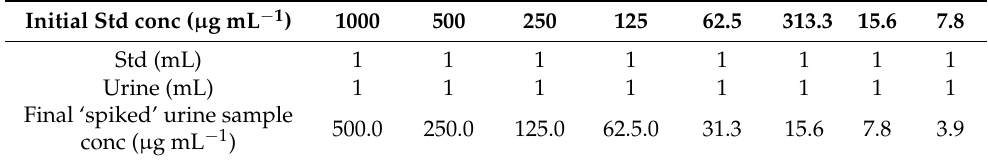
Table 5. Dilutions used for preparation of spiked urine samples for calibration